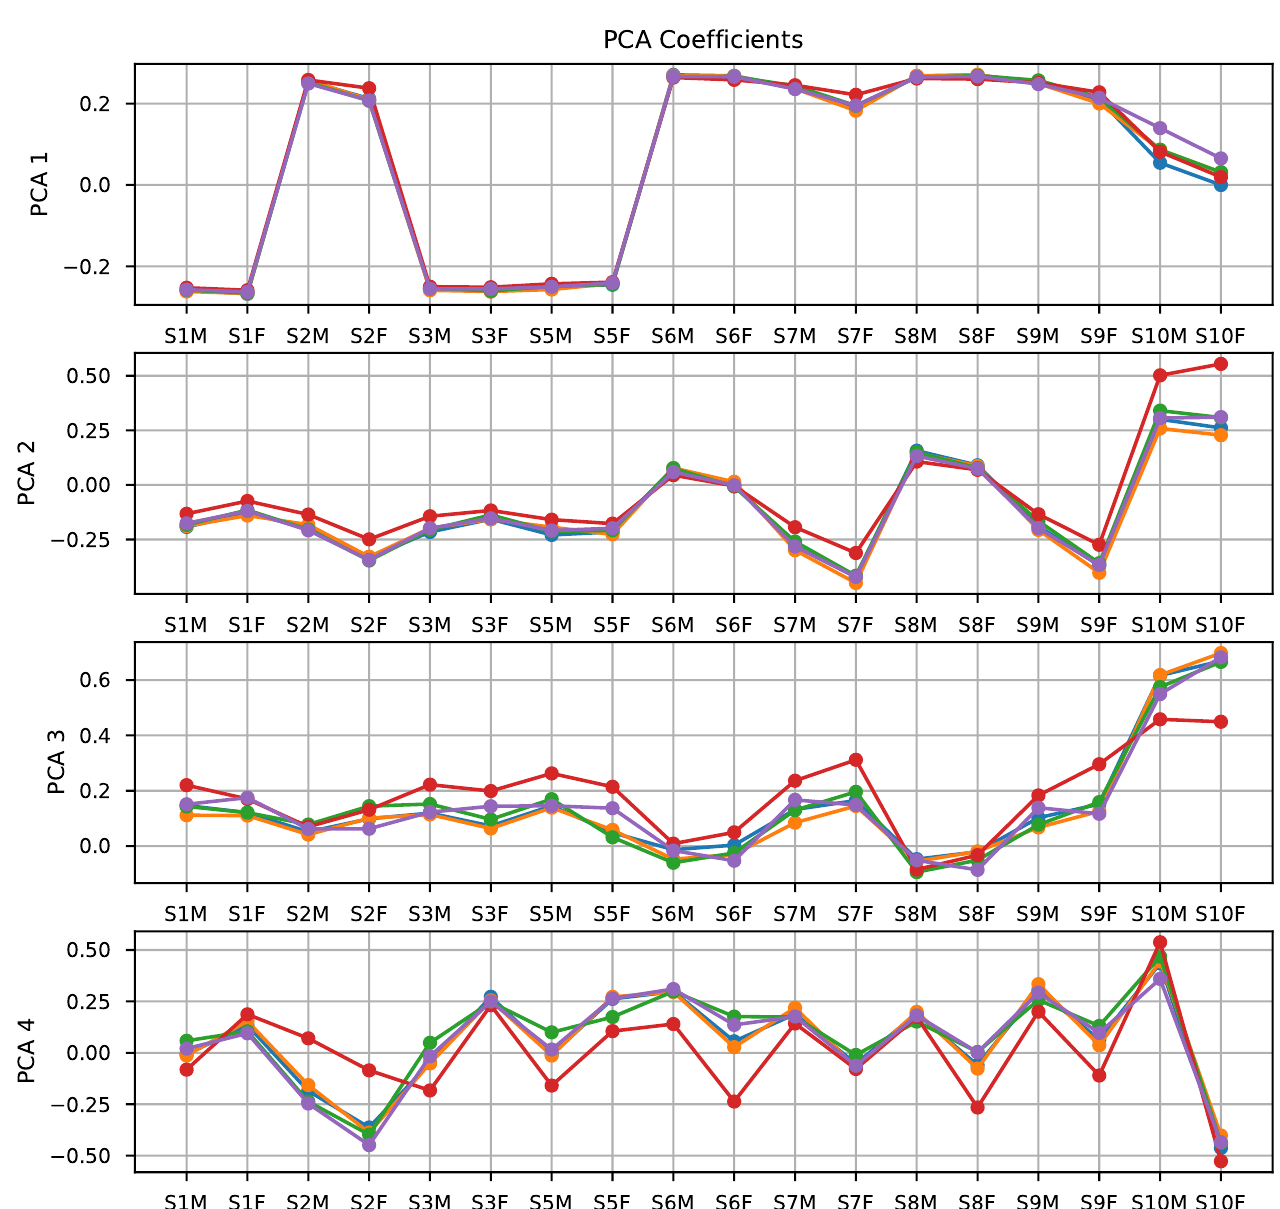
Figure 7. Visualization of the coefficients for the first four PCA components. Furthermore, Figure 8 shows the weights of the fitted models for both the SVM (top panel) and logistic regression (bottom panel). The inspection of these plots suggests that PCA components 2 and 4 are the most discriminative, as the coefficients associated with these components present a higher value than the others, particularly so for the SVM. The similarity of the coefficients yielded by both methods is noticeable, although not surprising taking into account the similarity of the optimization problems solved to obtain these parameters. The results obtained using this approach are included in Table 3. These results are not bad, but far from satisfying, particularly due to a lack of robustness shown as a large fluctuation of the classification score depending on the particular seed chosen for the random number generator responsible for the five-fold